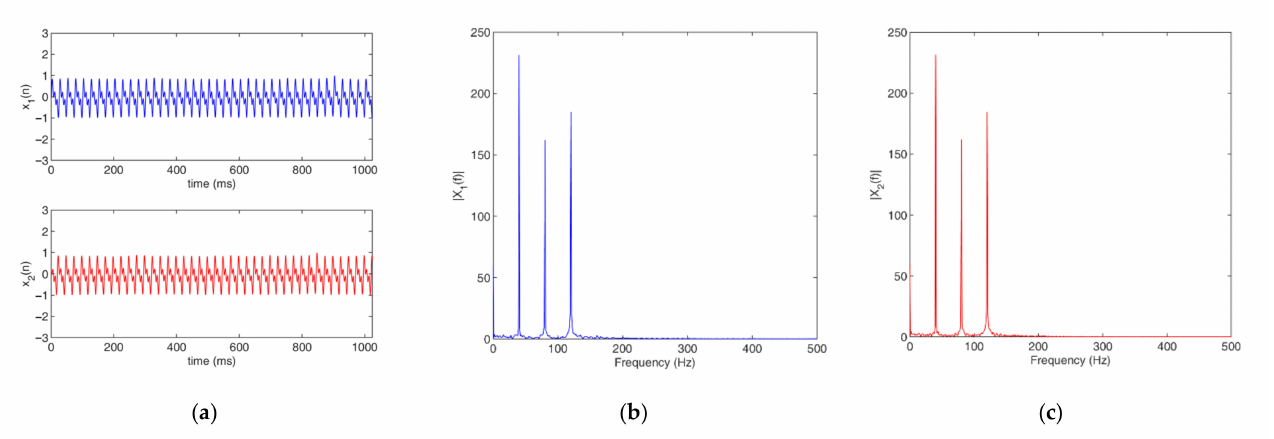
Figure 9. A typical example of signals with three strong periodicity components: ( a ) signals; ( b ) spectra of x 1 ( t ) ; ( c ) spectra of x 2 ( t )